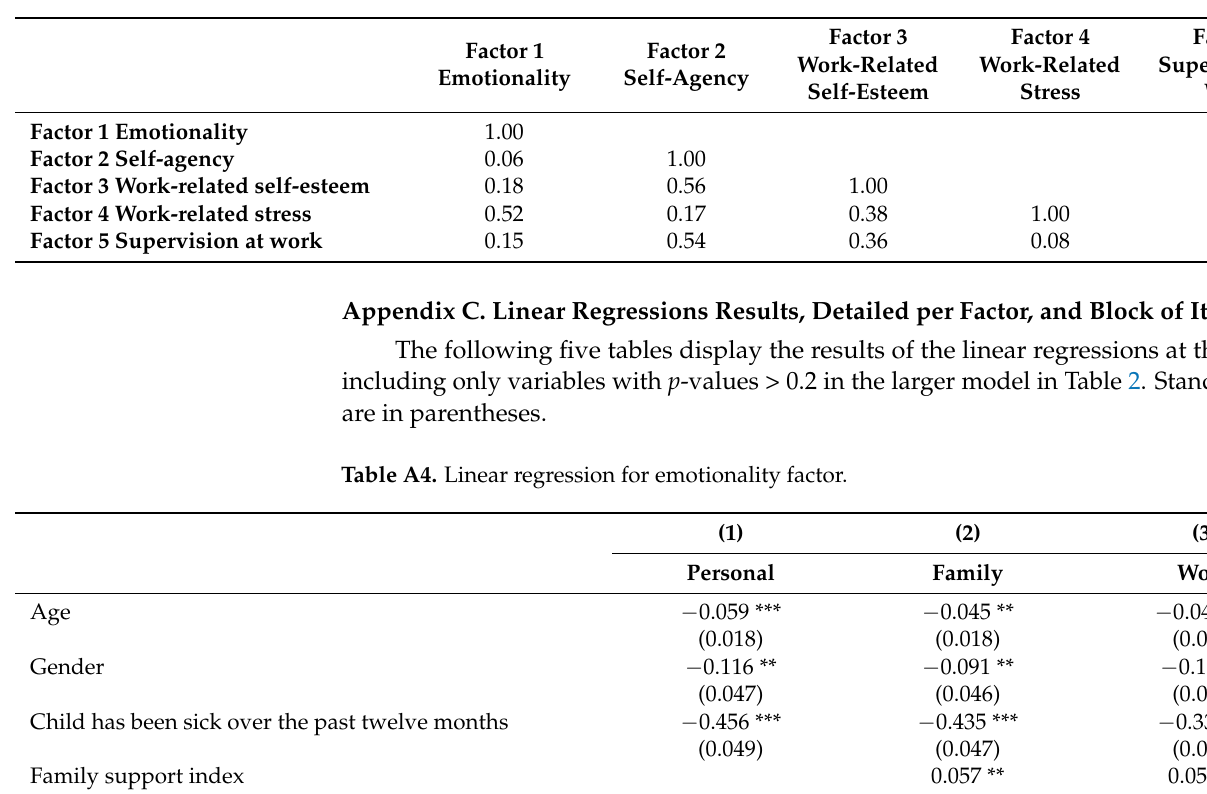
Table A3. Factor correlation matrix.